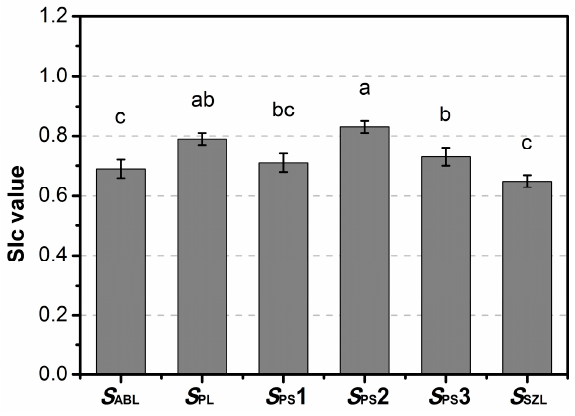
Figure 5. Spatial variations in the mean annual SIc values.